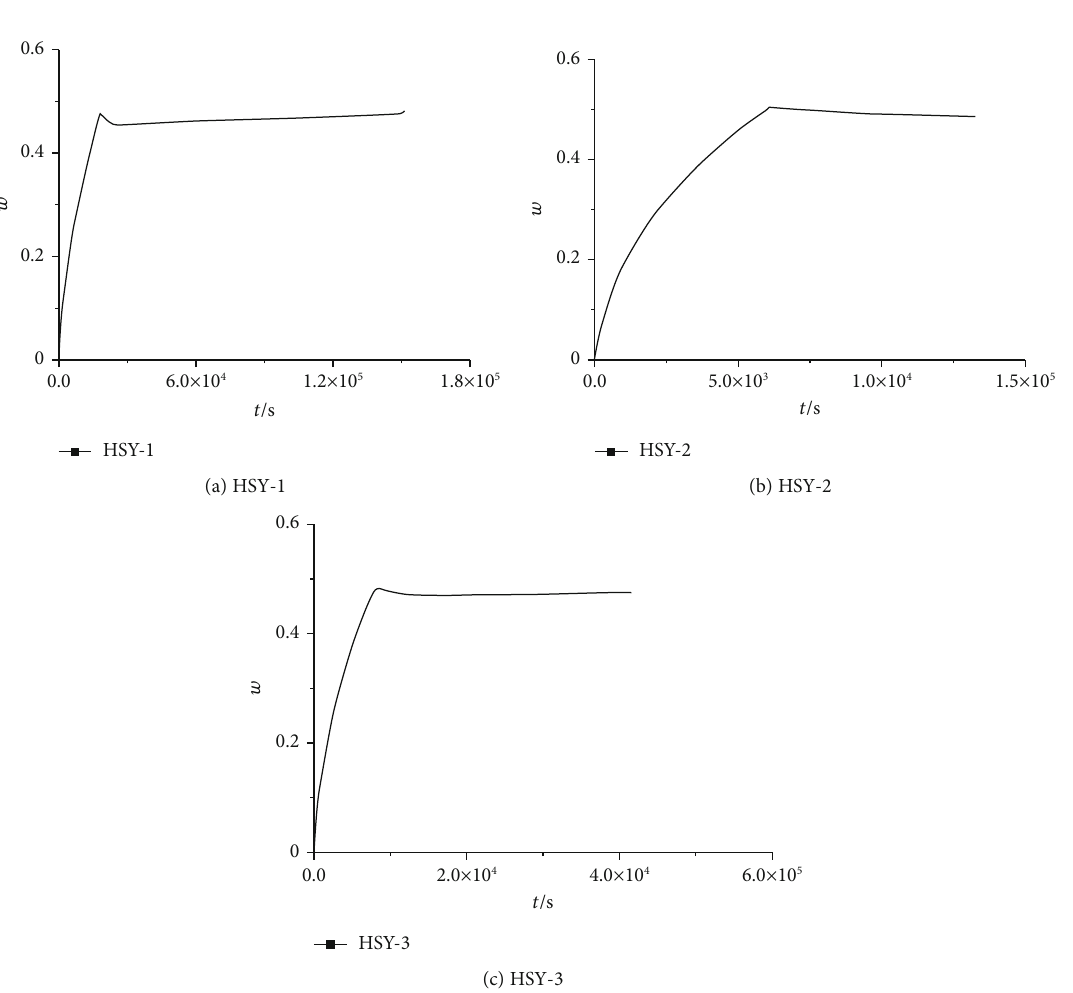
Figure 15: Black sandstone w – t curve of water absorption